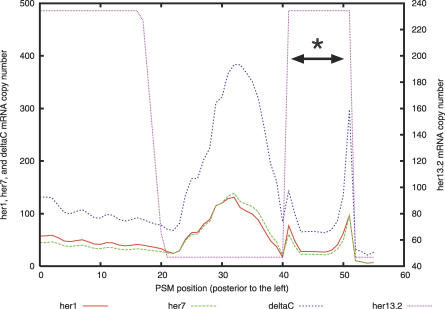
Simulated Grafting of an FGF-8 Coated Bead (Star)
her13.2 mRNA was assumed to be ectopically expressed, at the same level as in posterior PSM, in an area centered around the bead and marked by arrows.